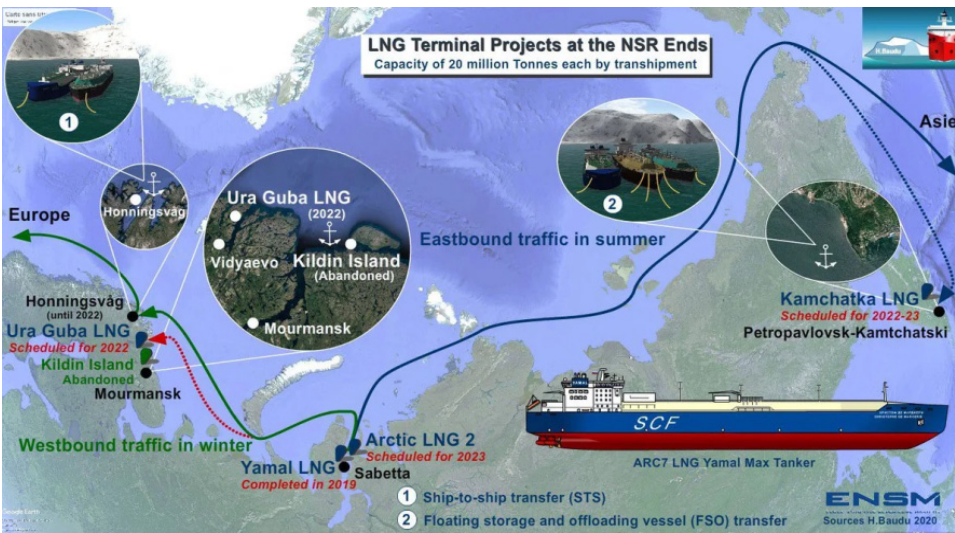
Figure 4. LNG transshipment terminals. Source: OJSC NOVATEK [56].